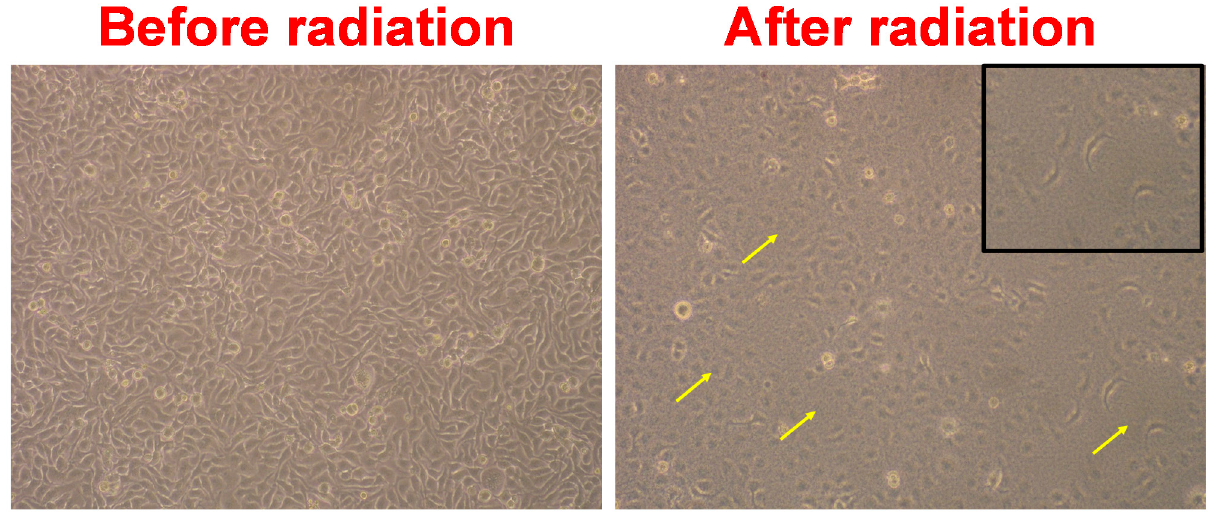
Figure 8. Microscopy images of NPC-BM1 cancer cells before and after photon radiation (8 Gy) at a magnification of 100X. The cancer cells were treated with GO (0.1 µg·mL − 1 ). The arrows and the inset image indicate cell damage.